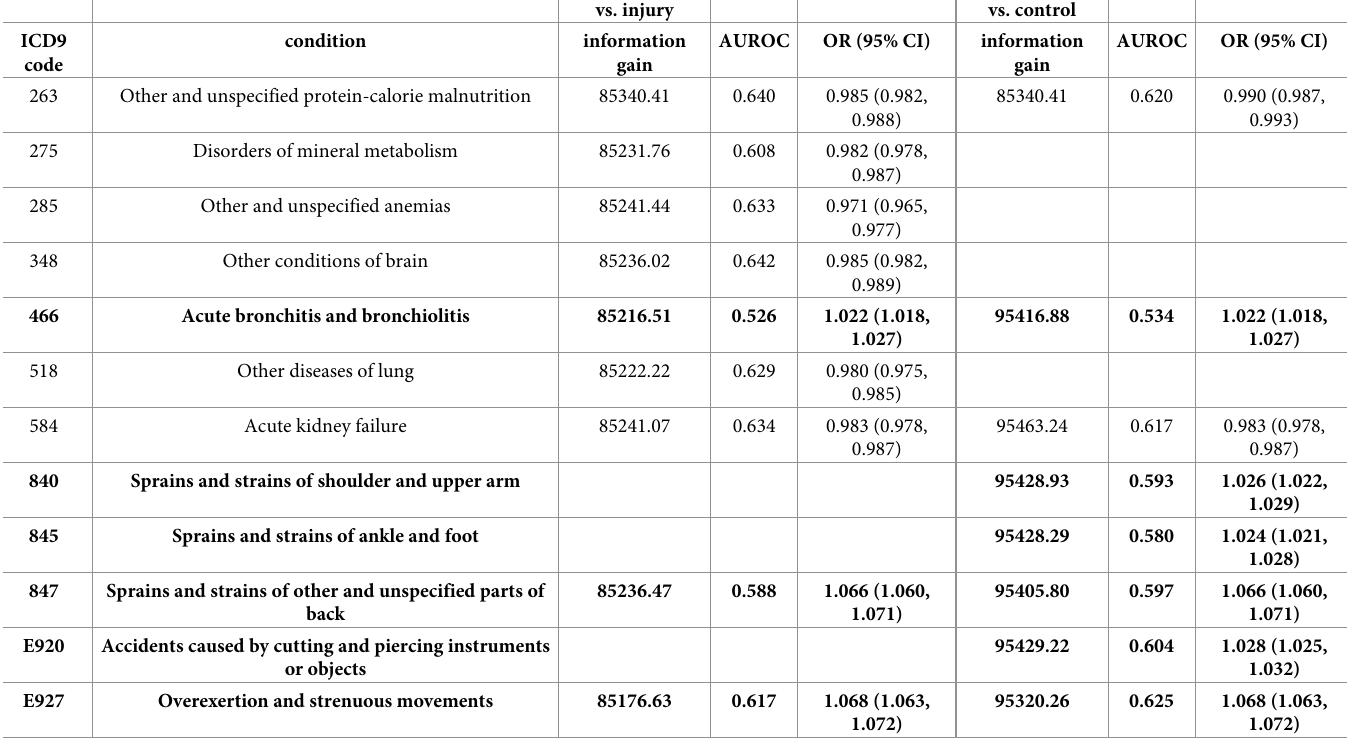
Next, we assessed the health consequences of WPI by evaluating the clinical diagnoses made after the injury (or after the corresponding baseline time for the random controls). After Bonferroni adjustment, at significance level of 0.05, a total of 166 variables were identified comparing WPI vs. IOP, and 176 variables for WPI vs. random controls. Fig 2 shows the top- 20 ICD-9 codes identified by merging the three distinct measurements of information gain, AUROC, and odds ratio (as absolute regression coefficient in the linear scale). Table 3 further Table 3. Health consequences differentially associated among WPI, IOP and random controls. Variable are ranked on the basis of combined AUROC, information gain, and odds ratio (OR). ORs are indicated along with their 95% confidence intervals (CI). vs. injury vs.